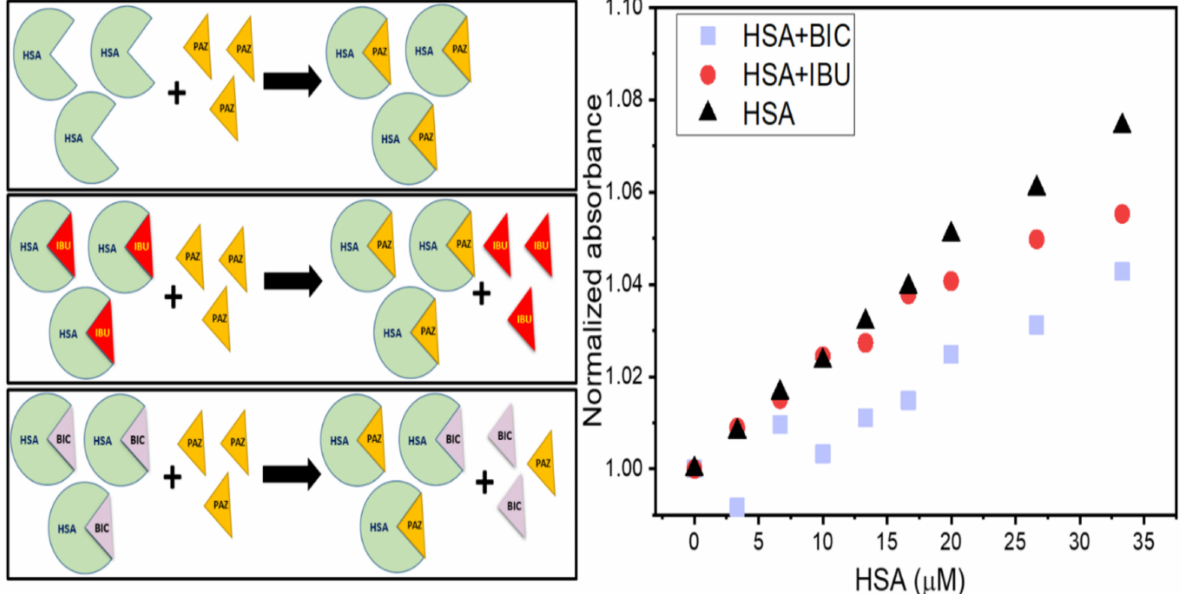
Figure 13. Schematic representations of competitive binding of PAZ to HSA in the absence of competitors ( above left ) and in the presence of IBU ( middle left ) and BIC ( below left ); UV absorbance responses of the competitive binding at 310 nm ( right